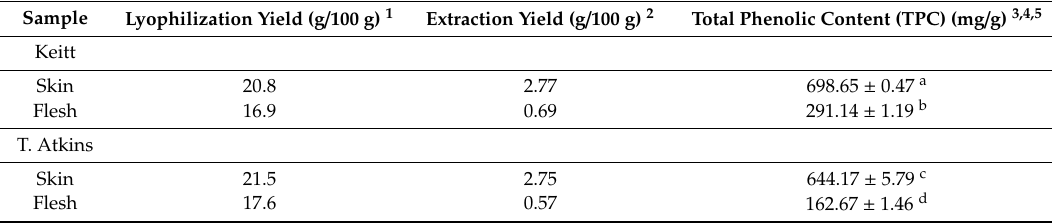
Table 1. Extraction yield and total phenolic